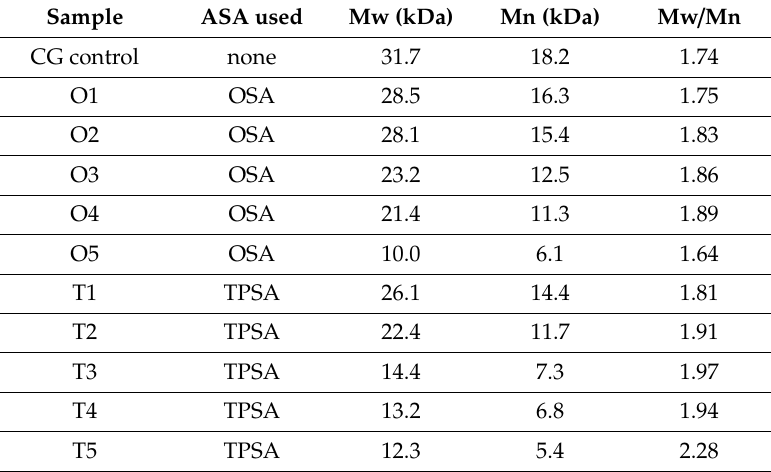
Figure 8. GPC data for CG–OSA adducts ( a ) and CG–TPSA adducts ( b ). Sample numbers are the same as given in Table 3. Table 3. Number-average (Mn) and weight-average (Mw) molecular weights for CG and modified